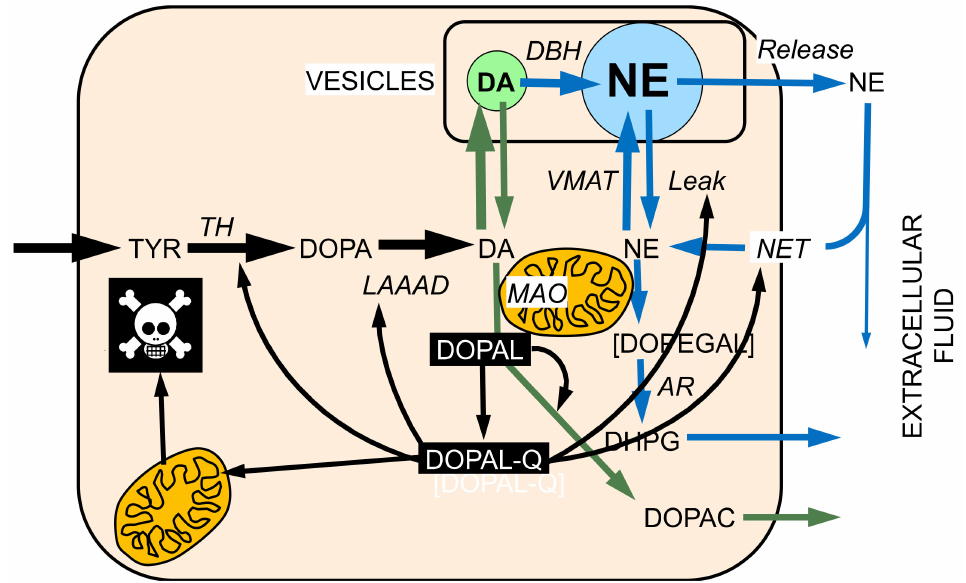
Figure 4. Intraneuronal effects of DOPAL buildup. DOPAL buildup in the neuronal cytoplasm may exert numerous harmful effects. These can be classified in terms of cytotoxicity via adverse effects on mitochondria and abnormalities from protein modifications, probably mediated by DOPAL quinone (DOPAL-Q). For instance, DOPAL inhibits tyrosine hydroxylase (TH) and L-aromatic- amino-acid decarboxylase (LAAAD). DOPAL can interfere its own detoxification by inhibiting aldehyde dehydrogenase (ALDH). DOPAL also decreases the storage of catecholamines in vesicles, by inhibiting the cell membrane norepinephrine transporter (NET) or the vesicular monoamine transporter (VMAT) or permeabilizing